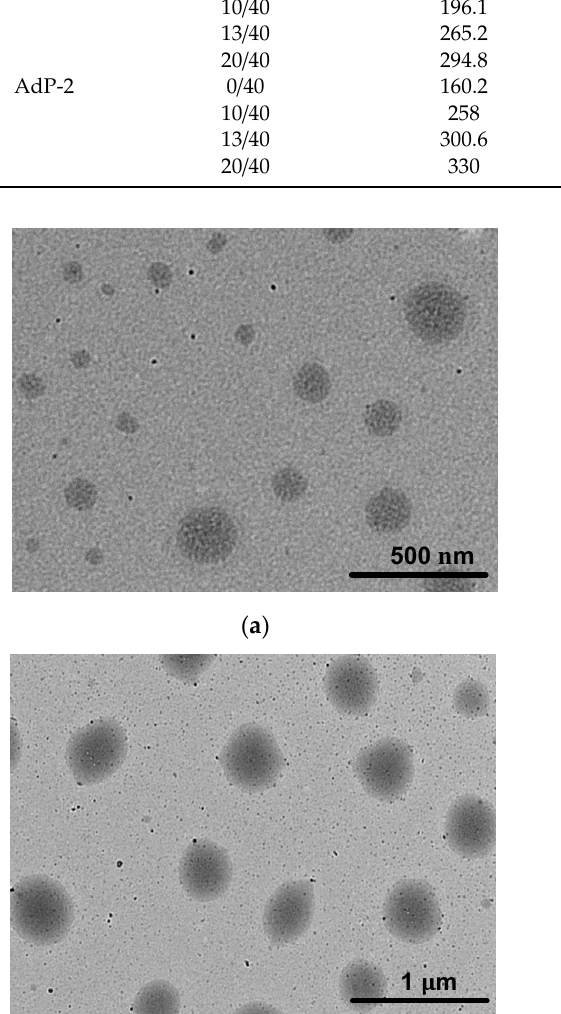
Figure 6. TEM images of AdP-1 blank micelles ( a ), AdP-2 blank micelles ( b ), AdP-1 PTX-loaded micelles ( c ) and AdP-2 PTX-loaded miceles ( d ).